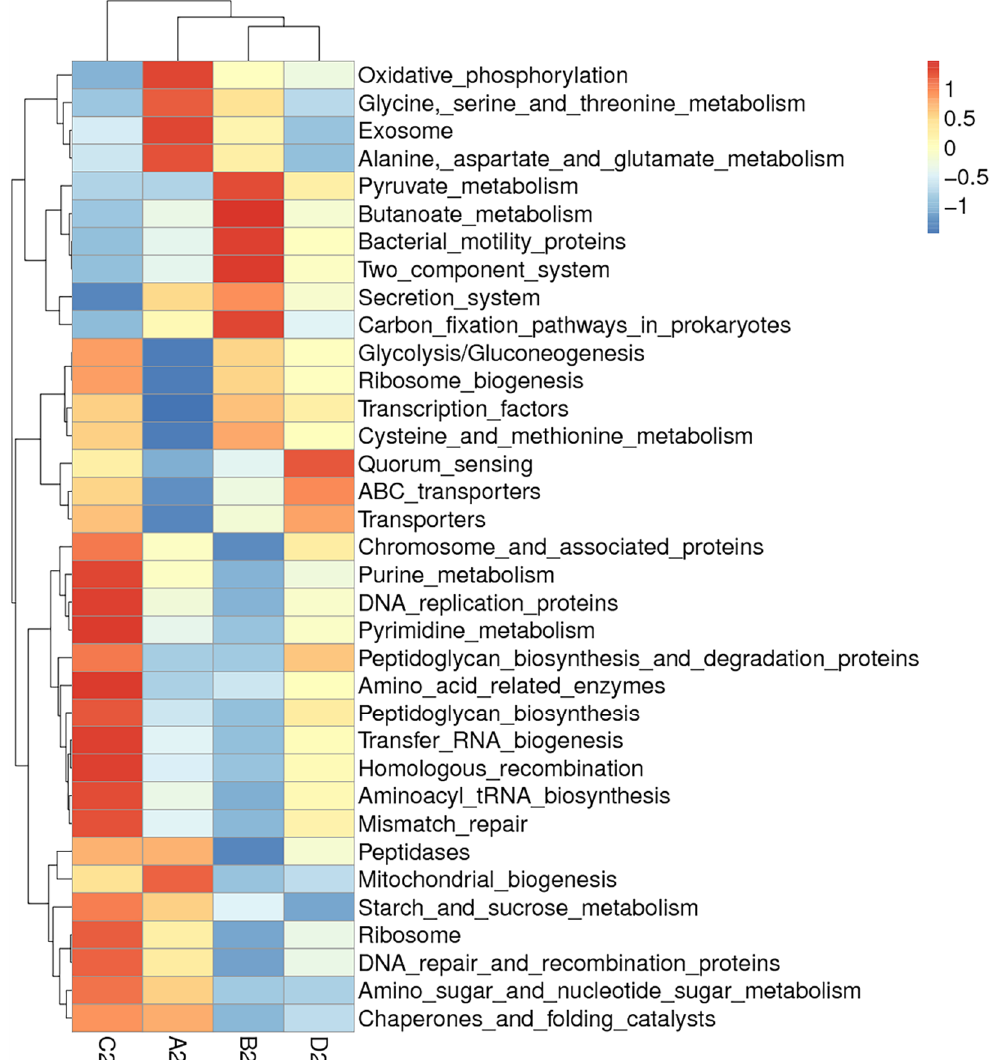
Figure 8. Hierarchical clustering heatmap of Tax4fun annotated function of bacteria in the ileal content. Note: The heatmap was constructed at the KEGG level 3 using the relative abundance of bacteria in the ileal contents from different groups of geese. The red or blue colors for a certain annotated function indicate that the relative abundance of bacteria in this group is greater or lower than the average relative abundance of bacteria across all the groups after normalization, respectively. Group A (as contro)l was fed a basal diet, the treatment groups (B, C and D) were fed the basal diet supplemented with 250 mg/kg Clostridium butyricum (viable count 3.0 × 10 6 CFU/g), 250 mg/kg Bacillus subtilis (viable count 2.0 × 10 7 CFU/g), or the combination of 250 mg/kg Clostridium butyricum plus 250 mg/kg Bacillus subtilis, respectively. n = 6.